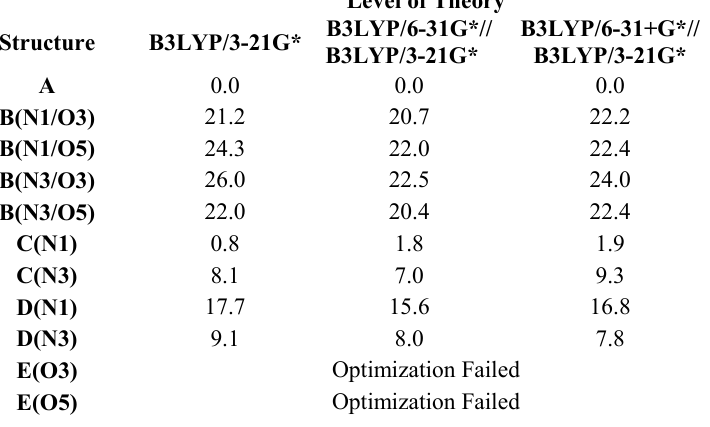
∗ , and B3LYP/6-31+G